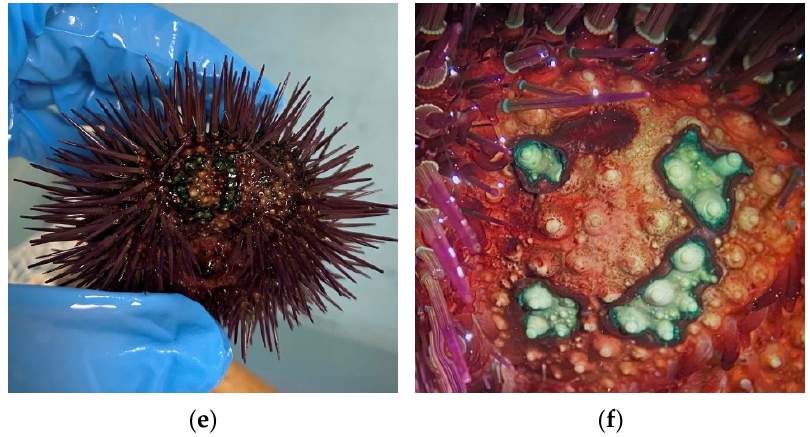
Figure 2. Specimens bearing external symptoms of bald disease at various stages. ( a ) Initial appearance of the disease is indicated by a slight loss of spines in the aboral region. ( b ) Lateral side contains a first appearance of whitish spots and loss of spines. ( c ) Extensive loss of spines and enlargement of diseased areas on the test. ( d ) Appearance of blue spots and initial corrosion of the test on the lateral side. ( e ) Extensive loss of spines and widening of the green spots. ( f ) Appearance of green spots and of a corroded area (dark spot) on the test observed under the stereomicroscope at 30×.